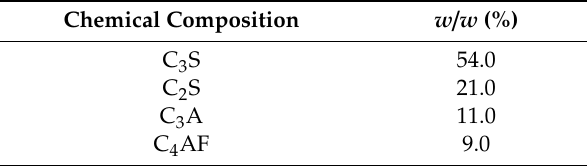
Table 1. The chemical compositions of Type I Ordinary Potland cement